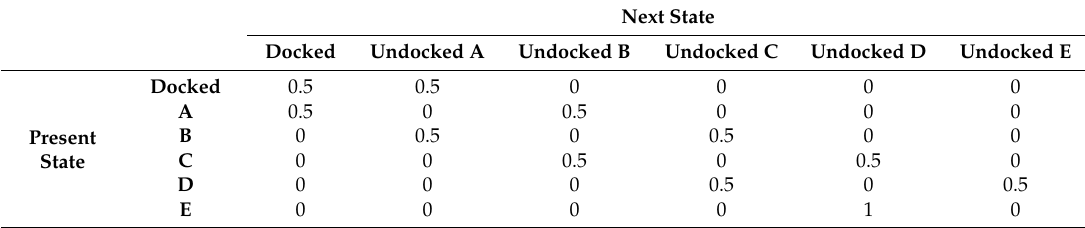
Table 8. State transition table of the emulated walk that follows Markov process—Activity level: Uncertain. Next State Docked Undocked A Undocked B Undocked C Undocked D